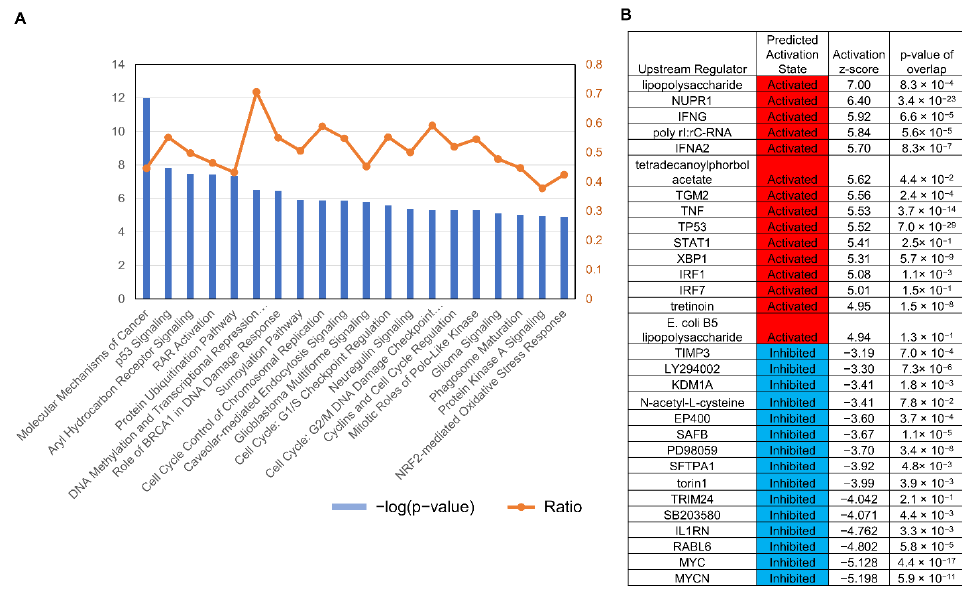
Figure 4. Evaluation of gene expression using serial analysis of gene expression (SAGE) analysis. ( A ) Selected significantly enriched canonical pathways identified using ingenuity pathway analysis (IPA). Diagram shows significantly overrepresented canonical pathways. Multiple-testing corrected p -value was calculated using Benjamini–Hochberg method to control rate of false discoveries in statistical hypothesis testing. Ratio represents number of molecules in given pathway that meet cut-off criteria, divided by total number of molecules that belong to the function. Brown, blue, and grey bars indicate positive z-score, negative z-score, and no available activity pattern, respectively. ( B ) List of top 15 and bottom 15 genes with major expression changes; red and blue show increased and decreased expression, respectively.